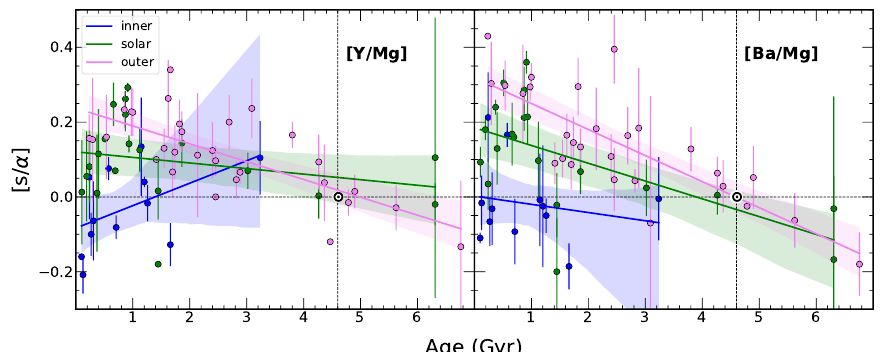
Figure 3. [s/ α ] versus age in three Galactocentric bins (outer disc in pink, R GC > 9 kpc; solar neighbourhood in green, 7 ≤ R GC ≤ 9 kpc; inner disc in blue, R GC < 9 kpc). The curves are the weighted linear fits to the data. In the left-hand panel we show [Y/Mg] versus ages, and in the right-hand panel [Ba/Mg] versus age. The data of individual clusters (abundance ratios are the mean values of the clusters members, while ages are from Cantat-Gaudin et al. [13], derived from Gaia DR 2 data) are represented by filled circles, in the same colours as the corresponding fits. The shaded areas indicate the confidence intervals of the